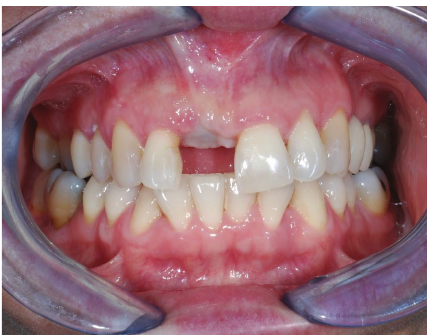
Figure 17: Frontal view following provisional pontic removal, after four months of healing.